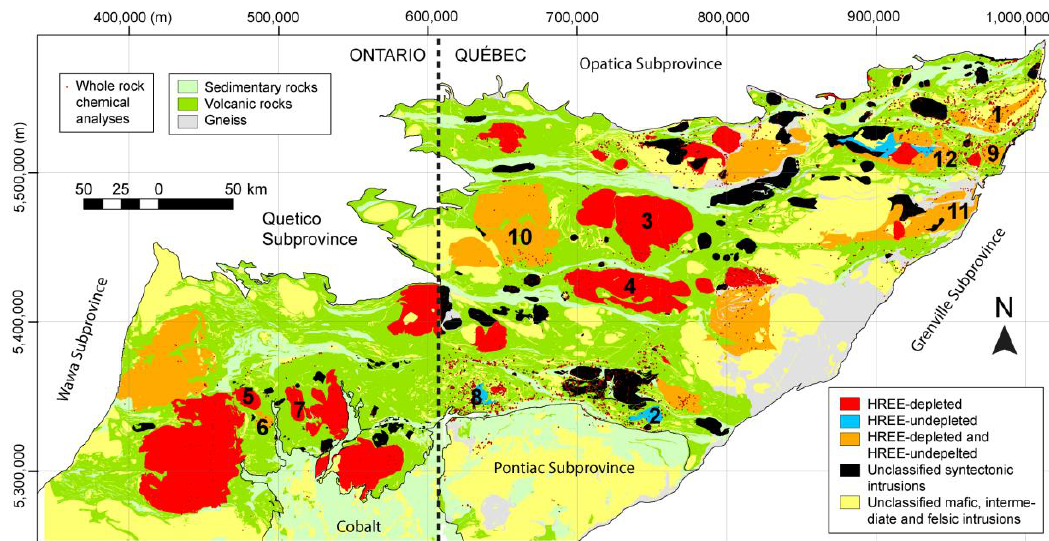
Figure 7. Geological map of the Abitibi Subprovince displaying intrusions with strongly fractionated ((La / Yb) N > 6) and less fractionated ((La / Yb) N < 6) REE profiles. Only tonalite, granodiorite, and diorite dominated intrusions are classified. The map is modified from the MERN and OGS datasets, and the projection is UTM NAD83 Zone 17 N. Numbers locate the Chibougamau (1) and Bourlamaque (2) plutons, the Marest (3) and Bernetz (4) batholiths, the Adams (5), Geikie (6) and Blackstock (7) plutons, the Powell, Flavrian, and Dufault plutons (8), La Dauversière (9), Mistaouac (10) and Hébert (11) plutons, and the Eau Jaune Complex (12).